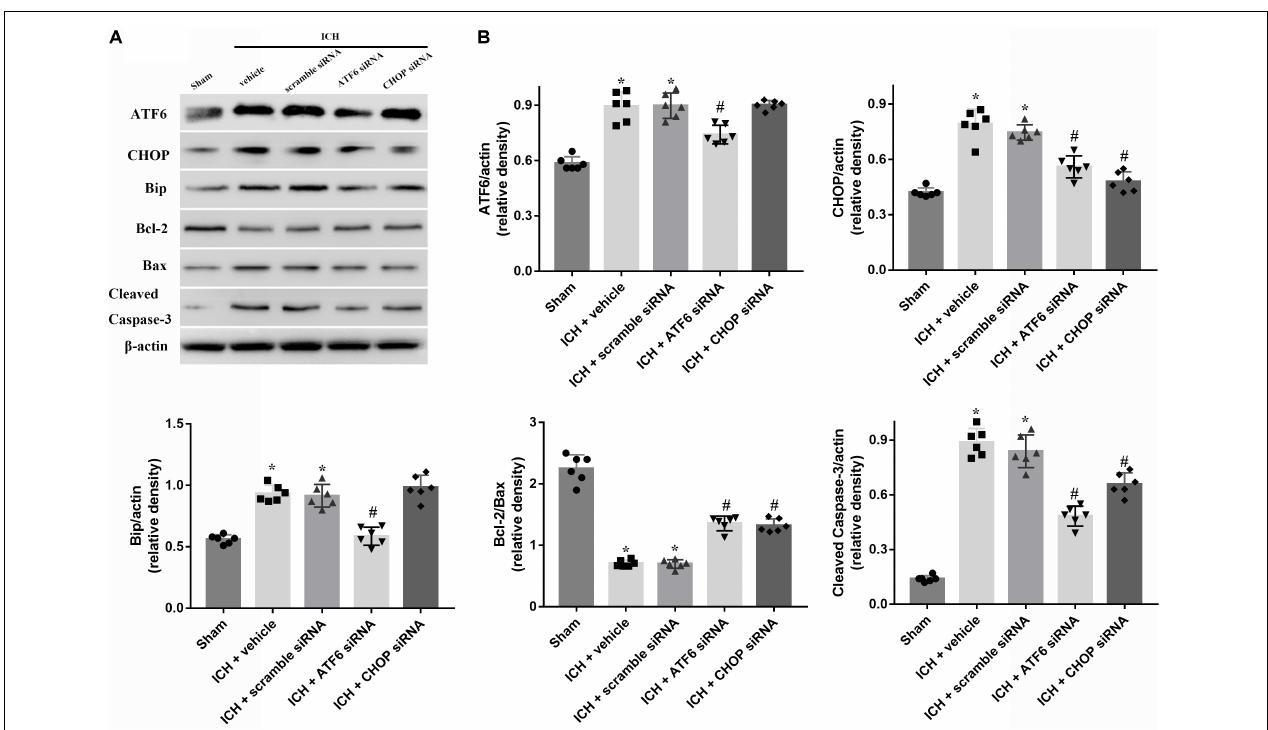
FIGURE 7 | Application of ATF6 siRNA promotes neuronal survival at 24 h after ICH. (A) Representative Western blot images. (B) Quantitative analyses of ATF6, CHOP, Bip, Bcl-2, Bax, cleaved caspase-3. n = 6 for each group. The bars represent the mean ± SD. ∗ p < 0.05 vs. sham, # p < 0.05 vs. ICH +